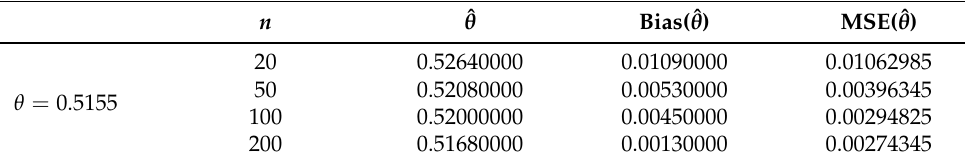
Table 2. Estimation for θ corresponding to moderate dependence. n ˆ θ Bias(ˆ θ ) MSE(ˆ θ )